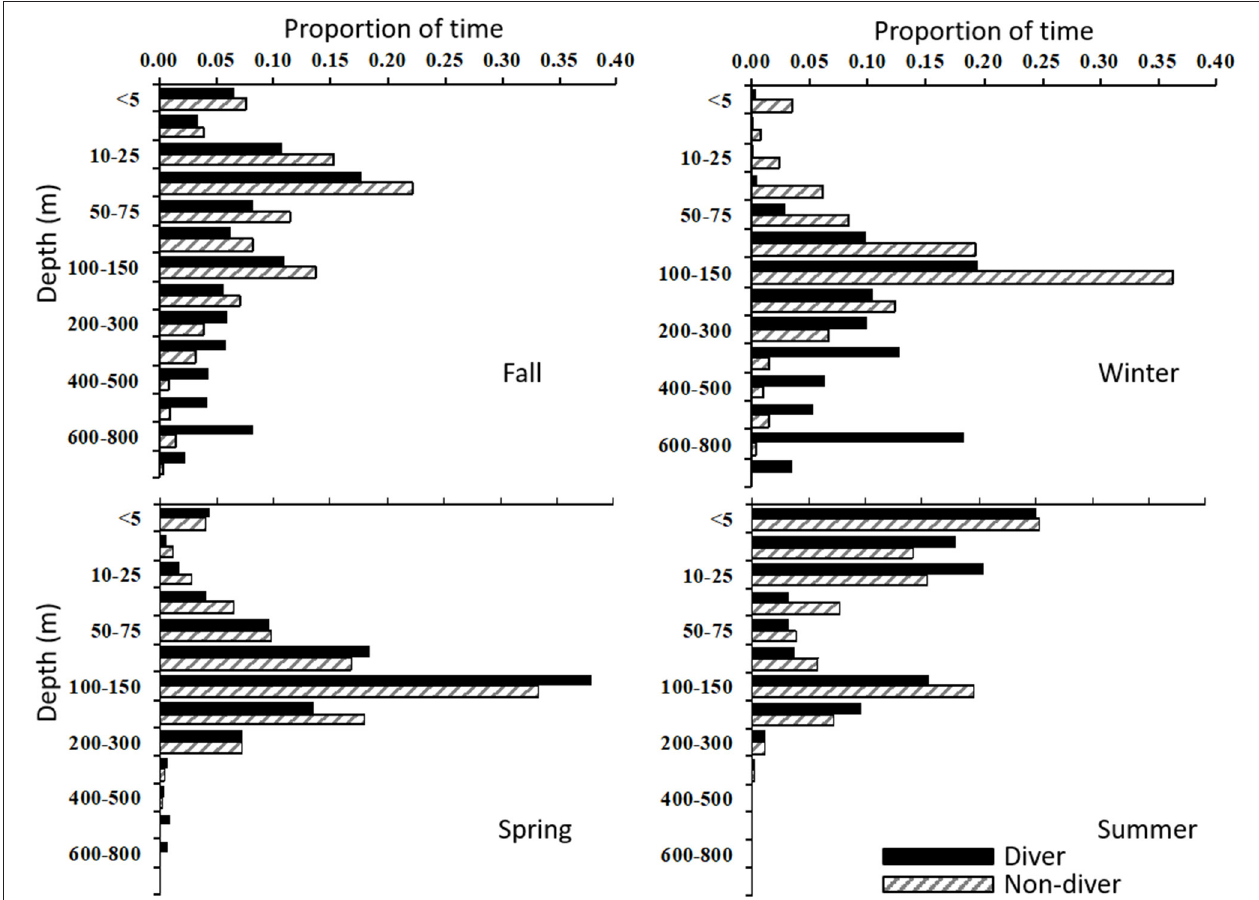
FIGURE 6 | Seasonal time-at-depth histograms for porbeagle divers (solid bar; n = 10) and non-divers (hatched bar, n = 7) tagged in the western North